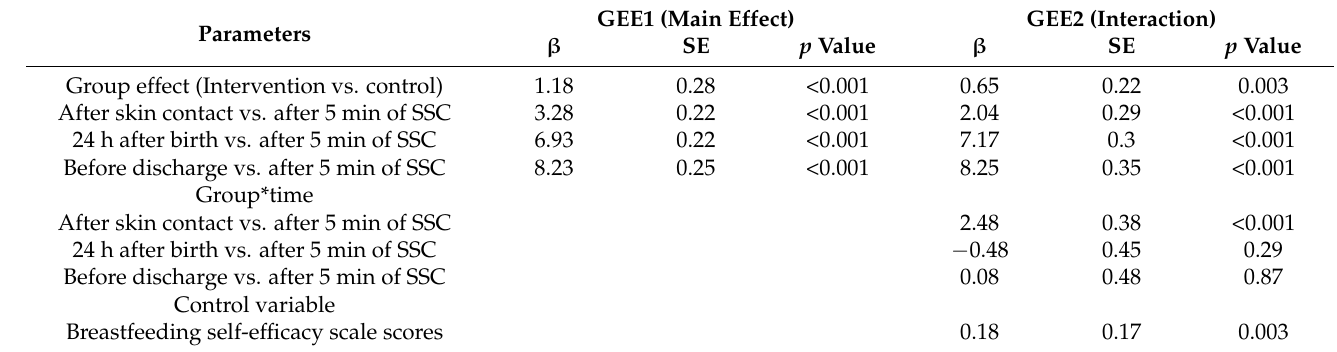
Table 4. Newborn sucking ability score comparison at different time points by the GEE